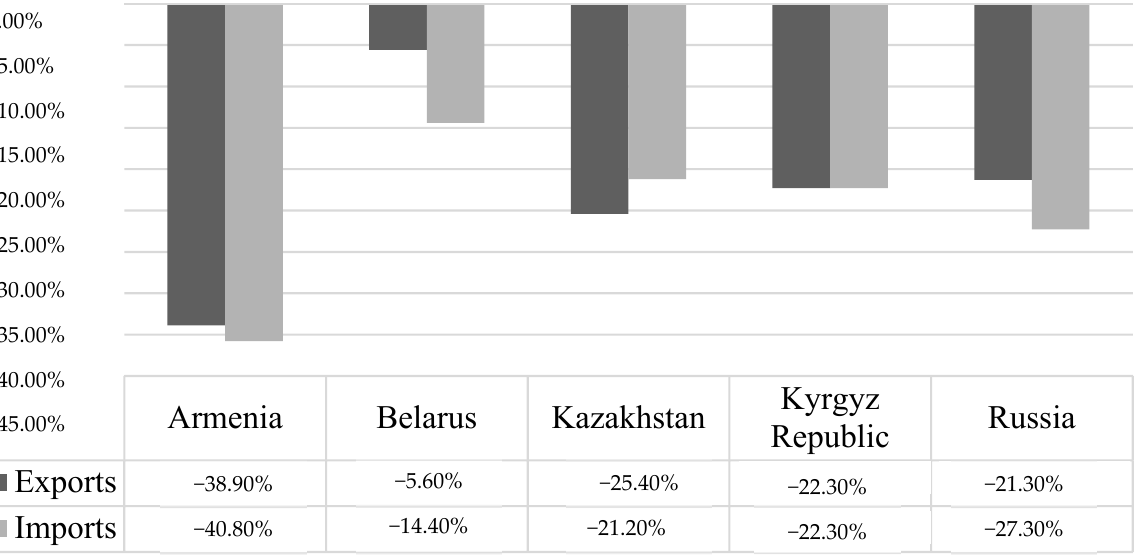
Figure 5. Decrease in the volume of trade in services in the EEU member States for 10 months of 2020 compared to 2019.